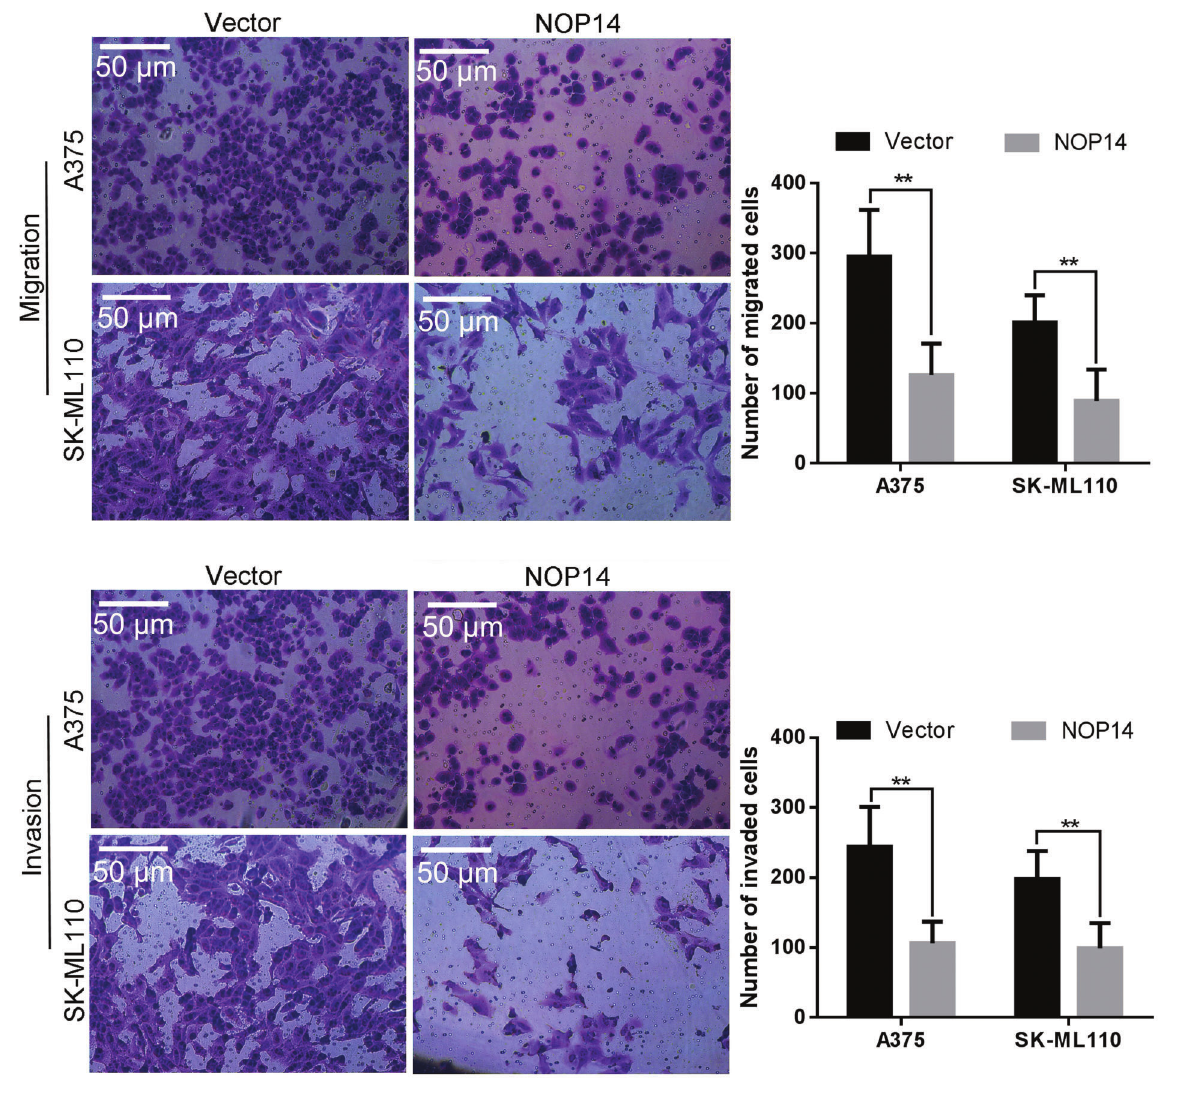
Figure 4. Migratory ability and invasiveness of melanoma cells determined by transwell assay. NOP14: nucleolar protein 14. Scale bar: 50 m m. Data are reported as means ± SD. **P o 0.01 vs empty vector ( t